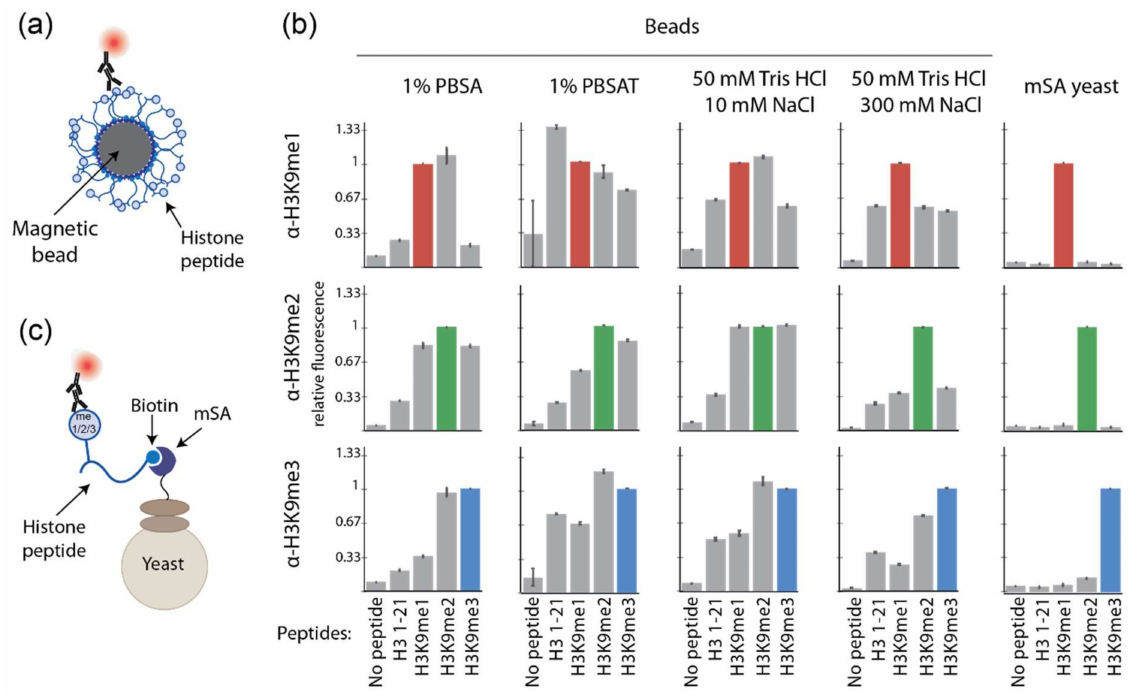
Figure 3. Antibodies label more specifically when histone peptides are presented on yeast versus bead surfaces. ( a ) Interaction between the peptide-coated magnetic beads and the corresponding primary and secondary antibodies. ( b ) Relative fluorescence of each peptide–antibody pairing. The pairings with expected specific interactions with each antibody are indicated by colored bars; error bars represent the standard deviation from triplicate samples. ( c ) Interaction between yeast displaying mSA, biotinylated peptide, and the corresponding primary and secondary